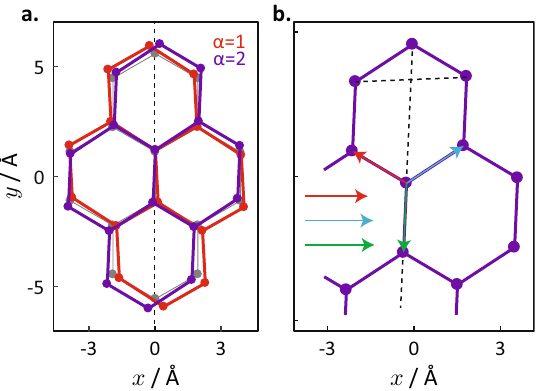
Figure 2. Compraison between strained and unstrained silicene lattices. ( a ) The unstrained silicene lattice (gray) and strained silicene lattices subject to uniaxial strain in the directions of α = 1 rad (red) and α = 2 rad (blue) with strain magnitude of γ = 1.1 (i.e. 10% elongation) for both. ( b ) A zoomed-in view of the strained silicene lattice for α = 2 rad and γ = 1.1 . The black dotted lines illustrate the breaking of the reflection symmetry under strain—the lines do not cross at right angles to each other. The three coloured arrows represent the displacement vectors (cid:31) d 1 , (cid:31) d 2 and (cid:31) d 3 from the central lattice point to its nearest neighbours. The arrows are redrawn and arranged horizontally at the lower left corner for comparison of their relative